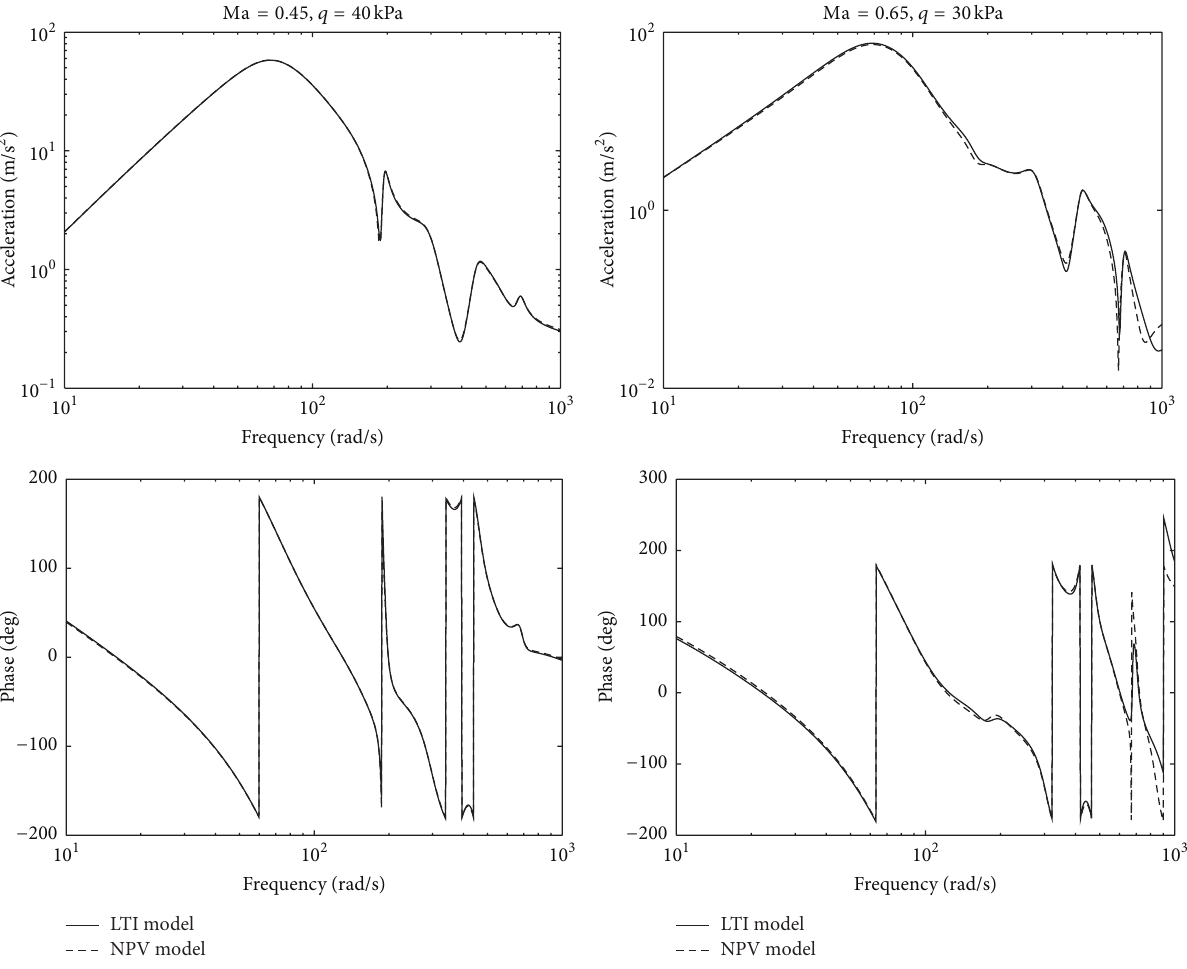
Figure 4: Bode plots from the inner control surface to acceleration of node 1 at two given flight conditions.